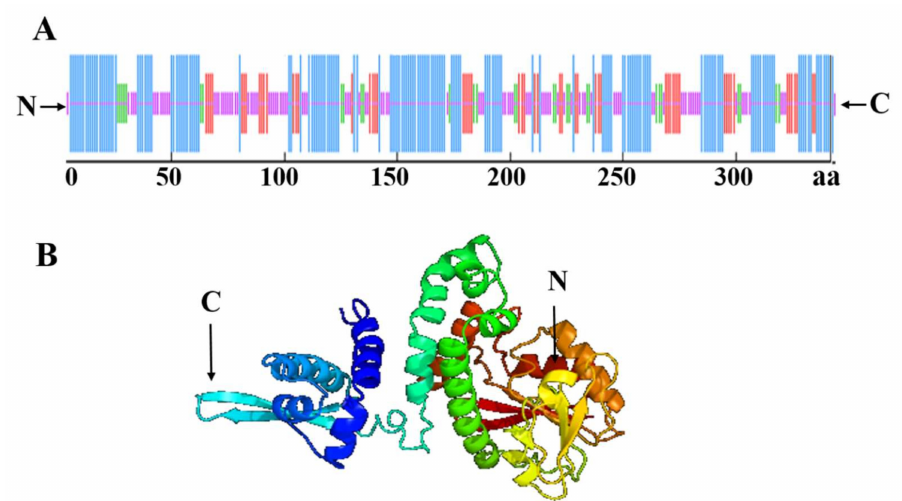
Figure 5. Structure prediction of the SlCOMT1 protein. ( A ) The secondary structure prediction of the SlCOMT1 protein. The blue indicates α -helices; purple indicates random coils; red indicates extended strands; green indicates β -turns; and the horizontal numbers indicate the positions of the amino acids. ( B ): The predicted three-dimensional structure of the SlCOMT1 protein.